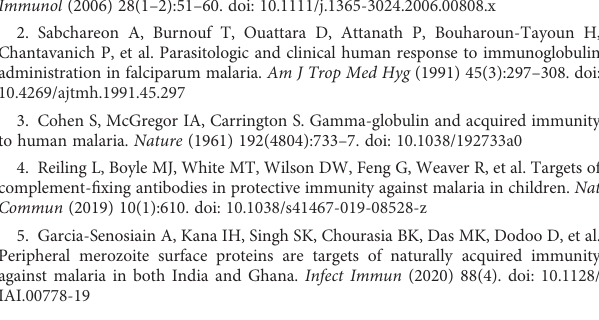
SUPPLEMENTARY FIGURE 1 Growth inhibition is concentration dependent. Normal plasma (Dark bars) and Heat inactivated plasma (Grey bars) were serially diluted to test the inhibition growth assay protocol. The pool included plasma from 10 hyperimmune